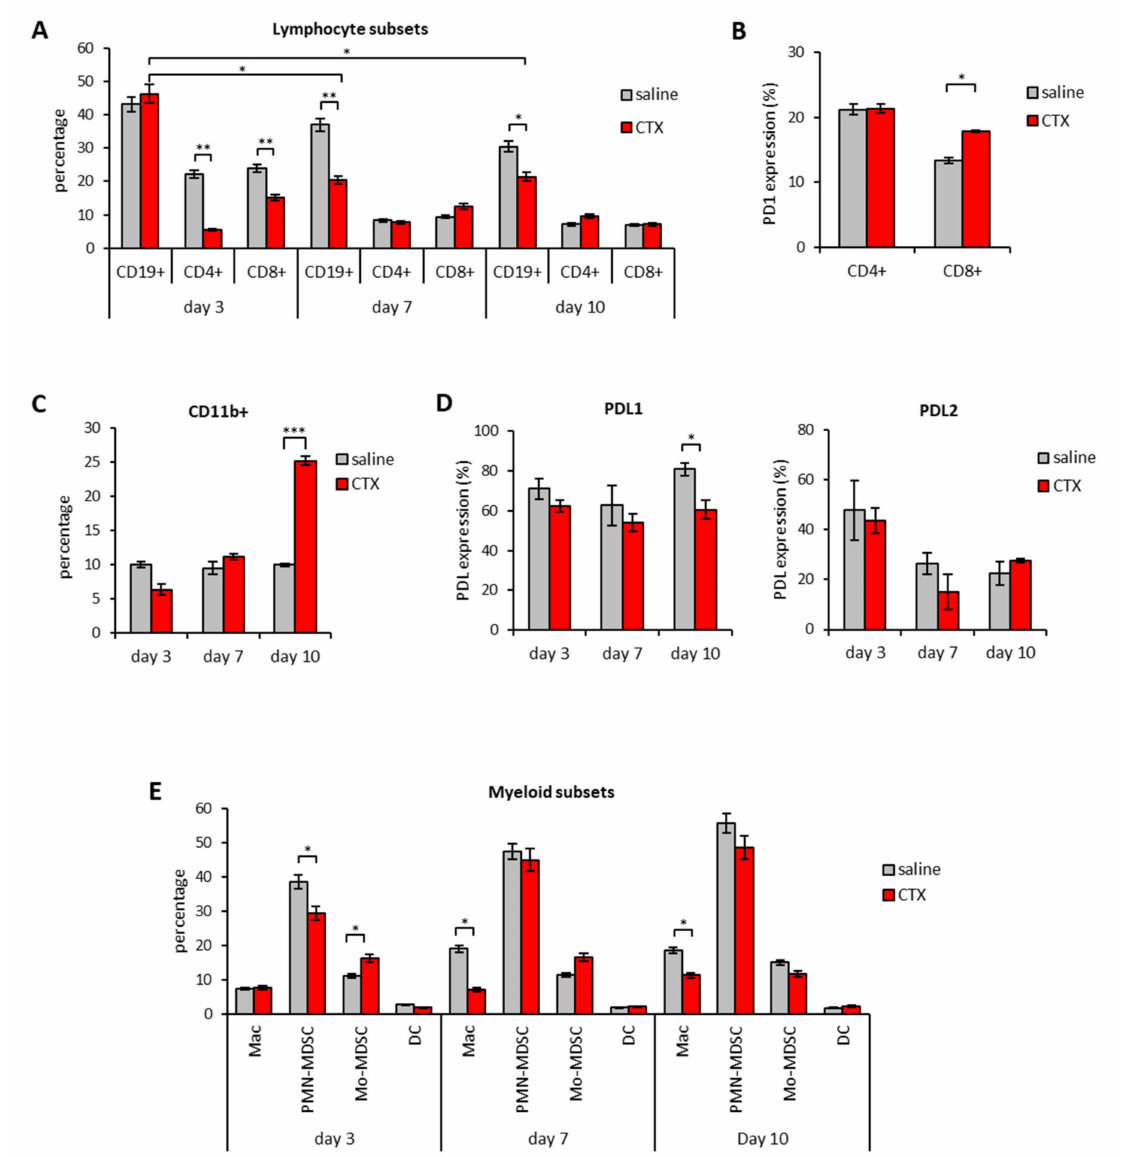
Figure 3. Modulation of PD1 / PDL molecules in the spleen of mice treated with CTX. C57Bl / 6 mice were treated with 100 mg / kg of CTX or with saline as control ( n = 5). Three, 7 and 10 days after treatment the leucocyte subset composition as well as the expression of PD1, PDL1 and PDL2 molecules was evaluated in the spleen by multicolor flow cytomtery. (A) Percentage of the indicated cell subsets in the spleen of saline or CTX-treated mice ( n = 5). (B) Percentage of PD1 expression in spleen T lymphocytes on day 7 after CTX or saline treatment ( n = 5). (C) Percentage of total myeloid cells and (D) of PDL1 and PDL2 expression in the spleen of mice treated with CTX or with saline as control ( n = 5). (E) Relative abundance of the indicated myeloid cell subsets in the spleen at di ff erent time-points from CTX or saline injection ( n = 5). All data are expressed as mean percentage ± SEM. * p < 0.05; ** p < 0.01; *** p < 0.005. NS = non